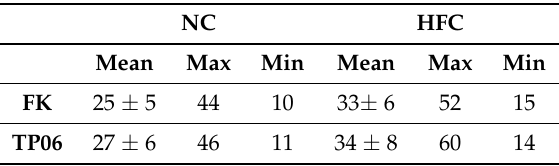
Figure 5. Ventricular fibrillation evolution for ( a ) FK and ( b ) TP06 ionic model within the heart failure case (HFC) heart induced via an S1–S2 protocol. Active regions ( V m > − 75 mV) are shown with colobar while infarcted zone (IZ) is depicted in light gray. Three times are selected showing the increase of scroll waves in accordance with the number of filaments shown in Figure 6. Table 3. Rolling averages of the number of filaments: mean and variance, maximum and minimum values after 2.5s from arrhythmia induction. Comparison among ionic (FK and TP06) and geometry (NC, HFC)